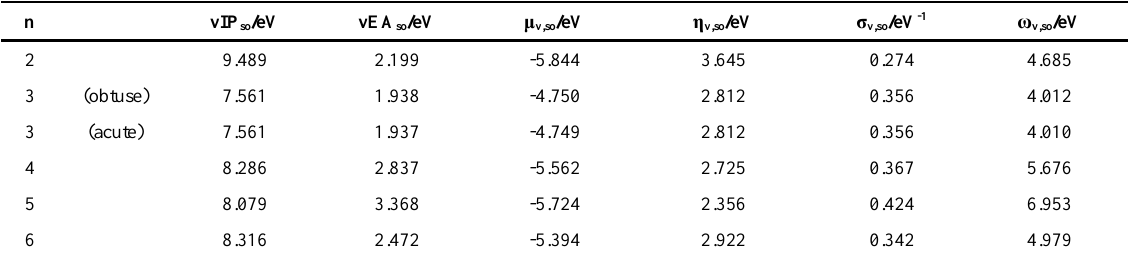
Table 3. Spin-obit corrected vertical ionization potential (vIP so /eV), vertical electron affinity (vEA so /eV), vertical chemical potential (μ v,so /eV), vertical hardness (η v,so /eV), vertical softness (σ v,so /eV -1 ) and vertical electrophilicity index (ω v,so /eV)